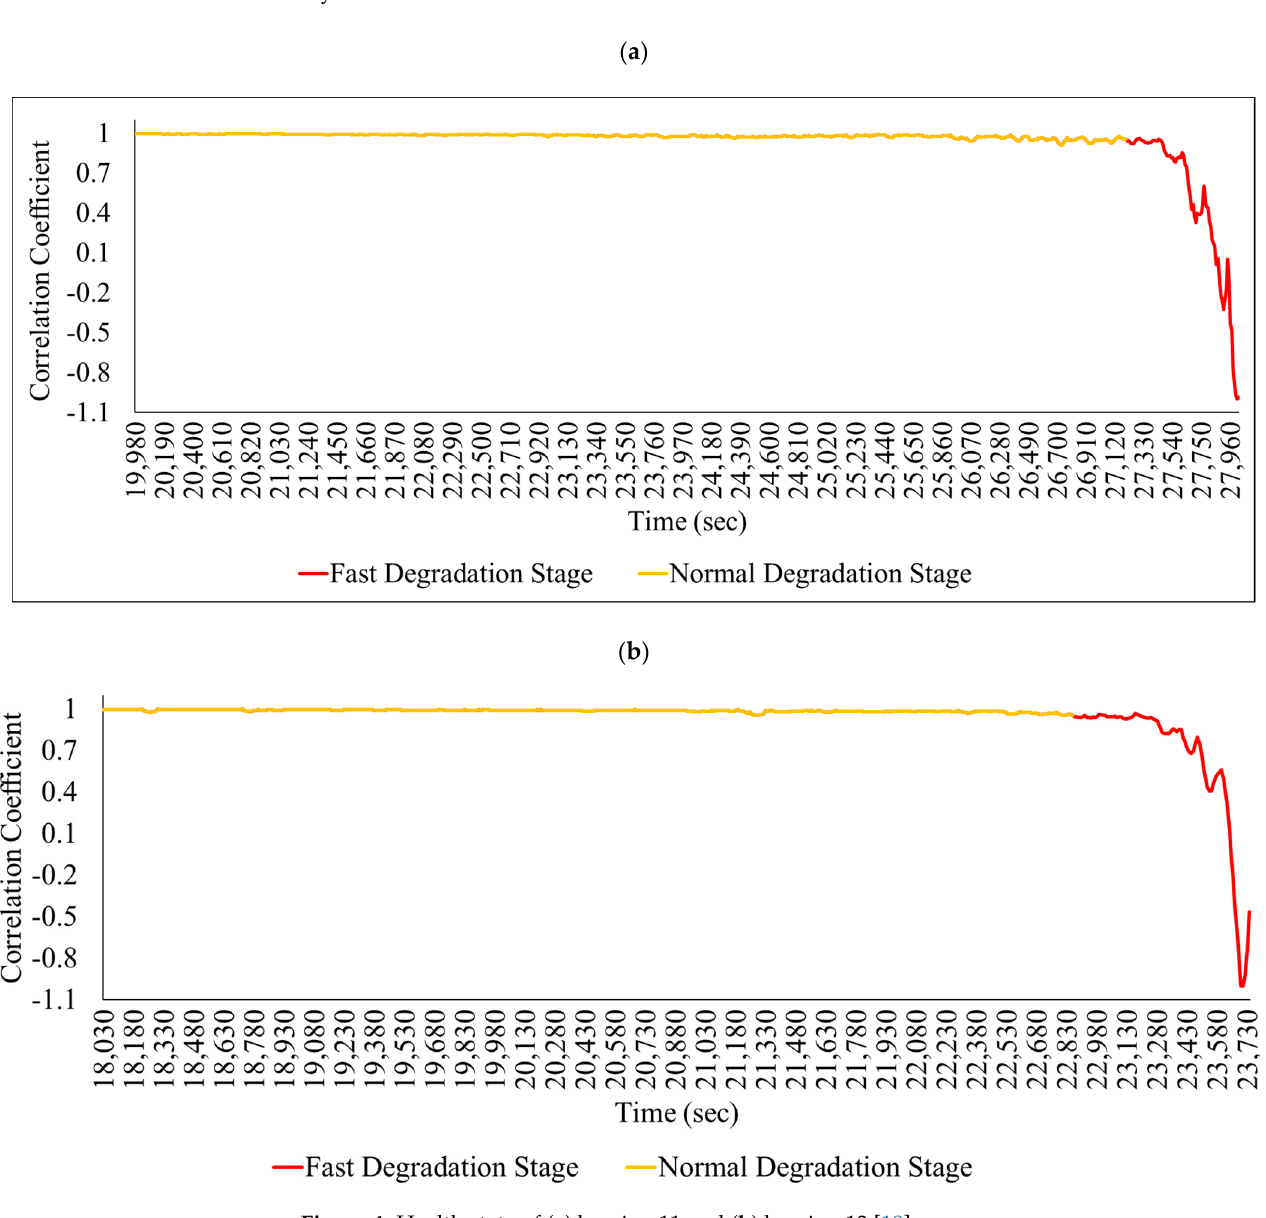
Figure 4. Health state of ( a ) bearing 11 and ( b ) bearing 13 [18].